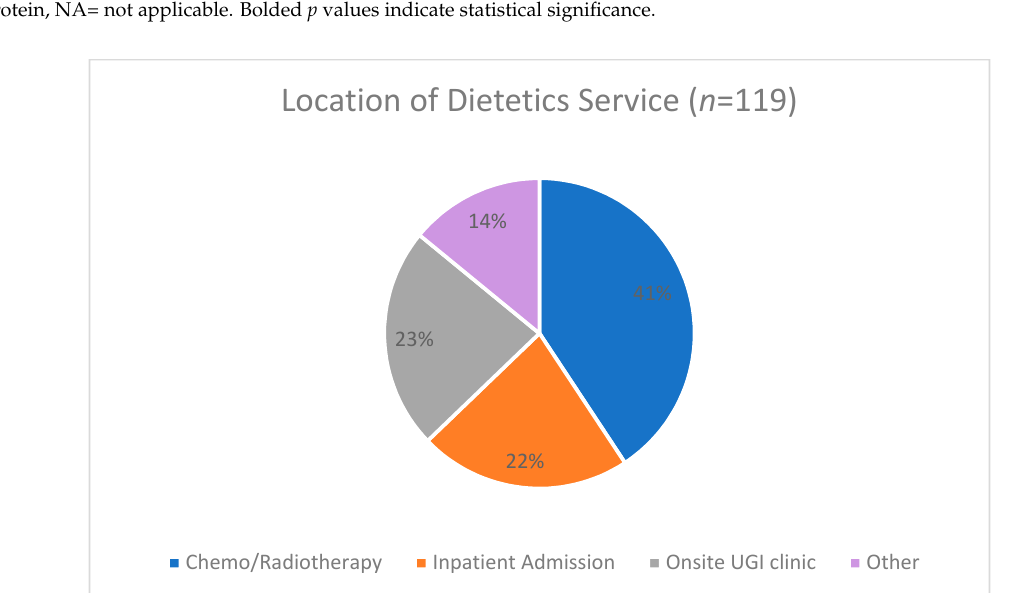
Figure 2. Differences between dietetics intervention received by patients undergoing oesophageal, gastric, and pancreatic surgery ( n = 119). 3.2. Factors Associated with Receipt of Dietetics Intervention and Nutrition Support On univariate model analysis, factors associated with receipt of preoperative dietet- ics intervention included malnutrition and neoadjuvant therapy, whilst pancreatic sur- gery and associated tumour types were associated with a reduced likelihood of receiving